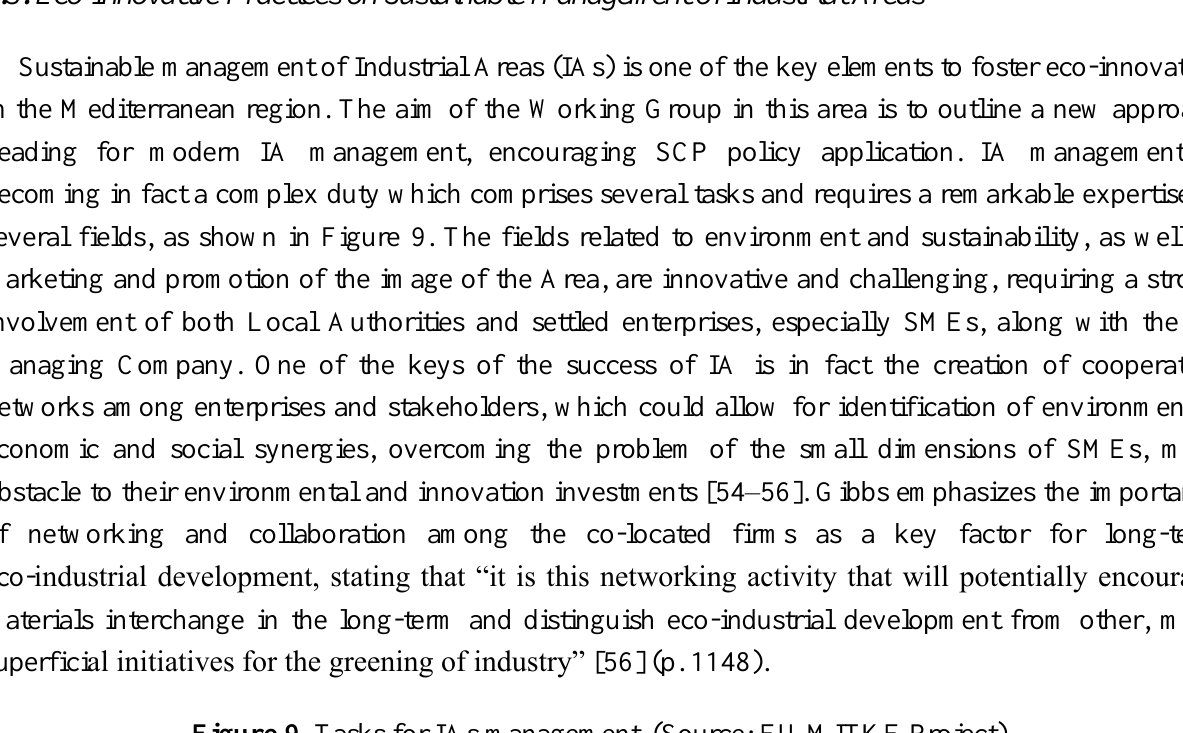
Figure 9. Tasks for IAs management (Source: EU MITKE